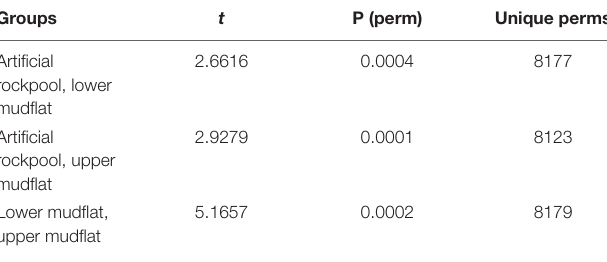
TABLE 3 | Pairwise tests for PERMANOVA between soft-bottomed habitats on species abundance data (Number of permutations = 9999).